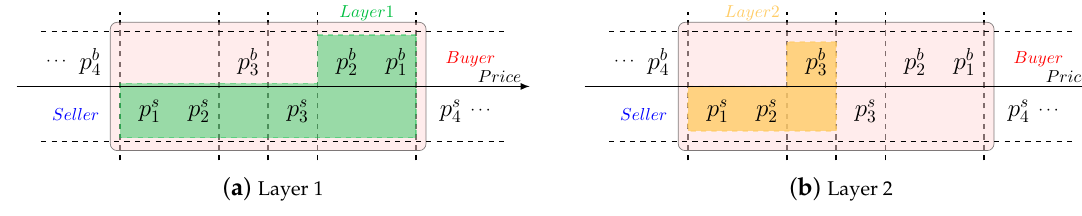
Figure 3. Layering methods in the proposed sharing